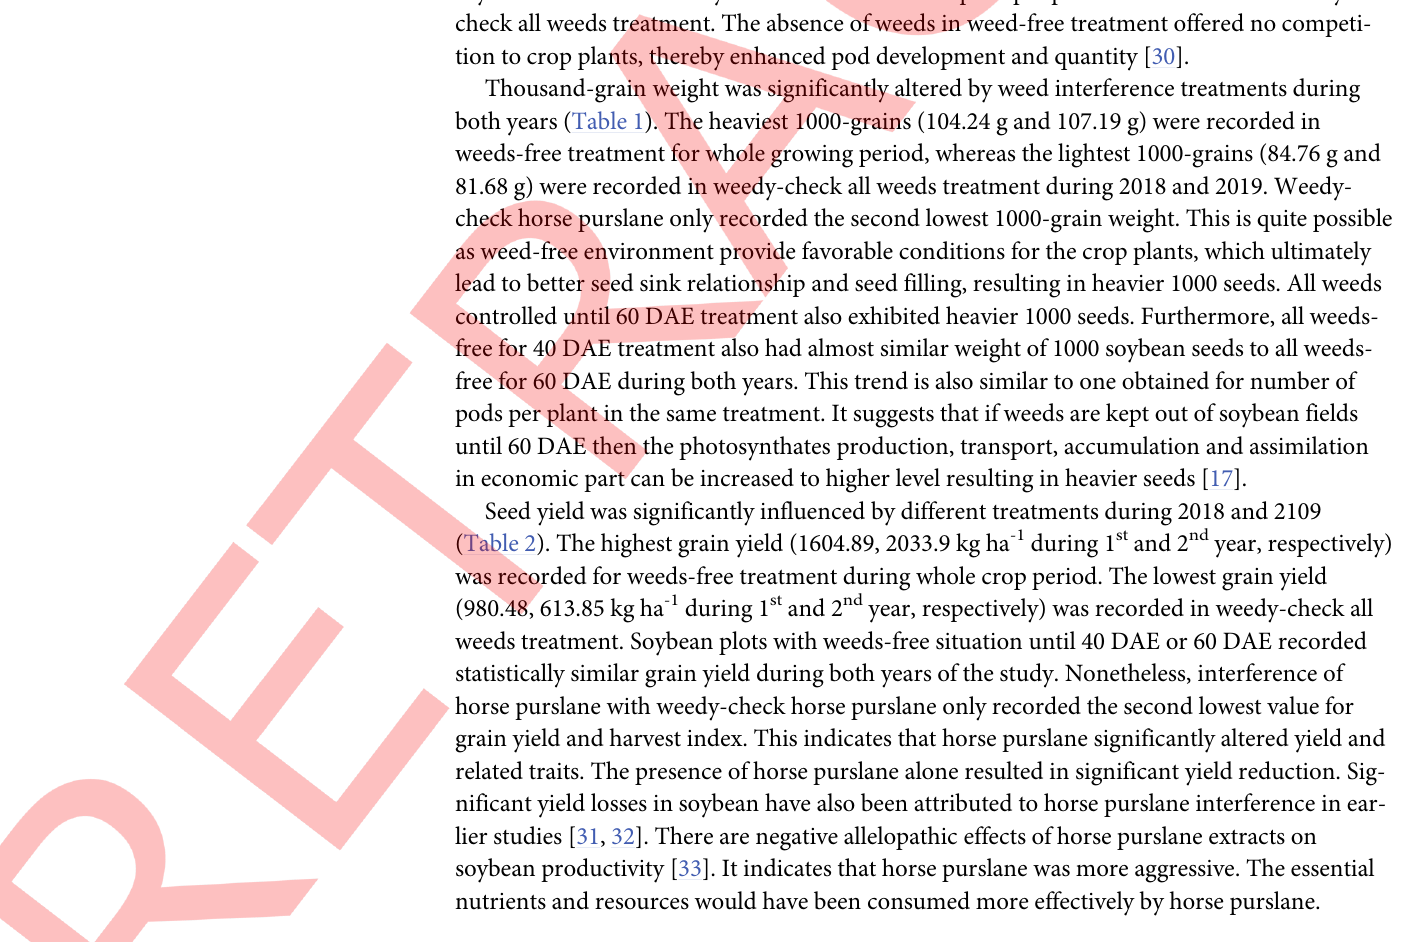
soybean” used in this study. The lowest number of pods per plant were recorded in weedy- check all weeds treatment. The absence of weeds in weed-free treatment offered no competi- tion to crop plants, thereby enhanced pod development and quantity [30].